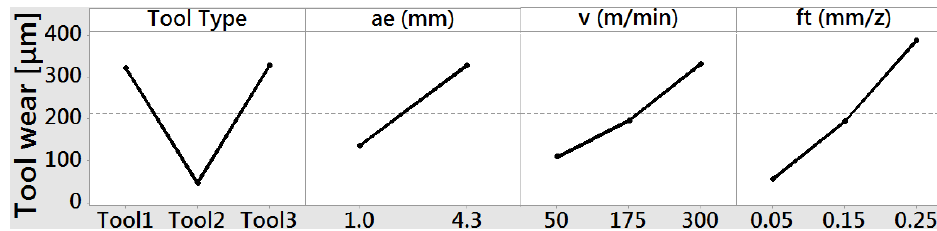
Figure 22. Main effect plot for tool wear.